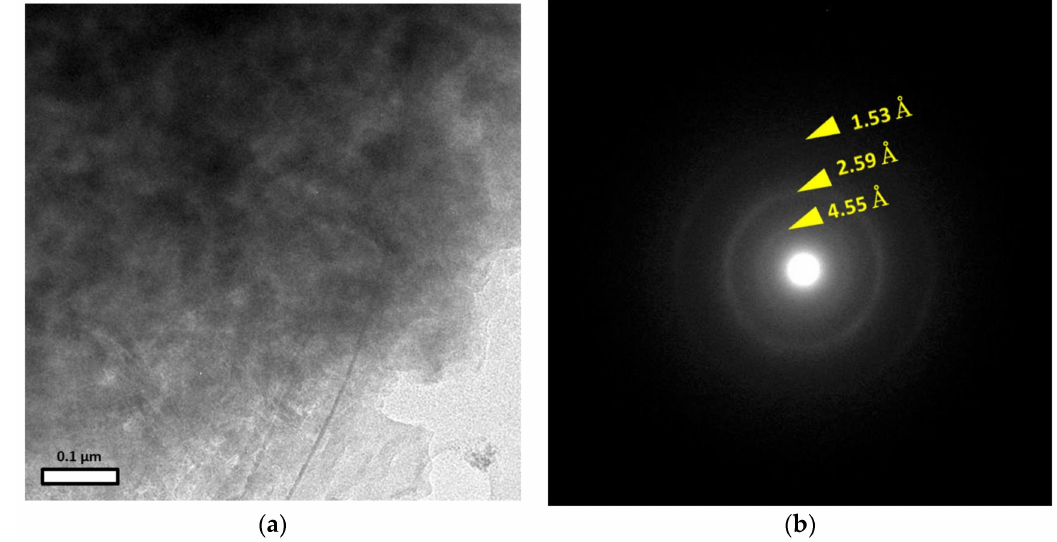
Figure 7. TEM results for the solid phase with Si, Fe, and Mg, in the matrix of the clastic sediments from DH4 at 3 m: ( a ) Low magnification image; ( b ) SAD pattern of the area in ( a